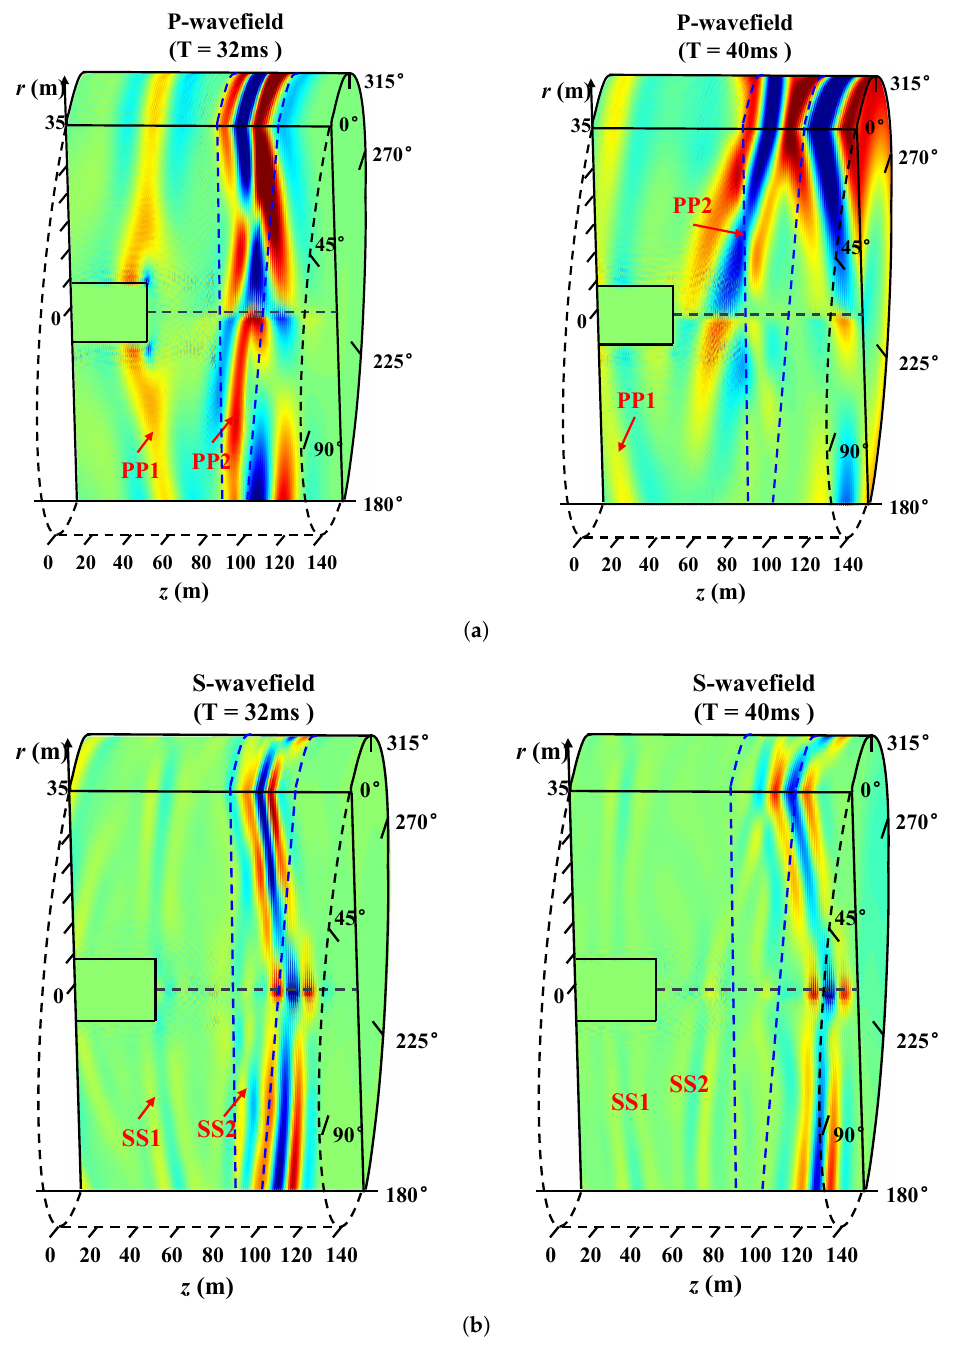
Figure 8. 3D P - and S -wavefields at different times of the wedge fault model. ( a ) 3D wavefield snap- shot of P -wavefield at different times. ( b ) 3D wavefield snapshot of S -wavefield at different